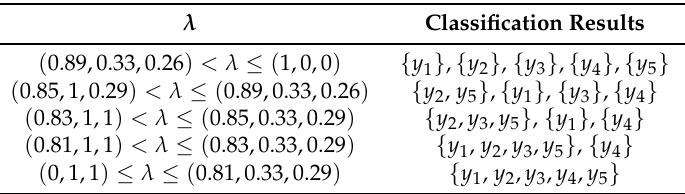
Table 2. Clustering result of ( T , S ) -SVNNEM of type I.